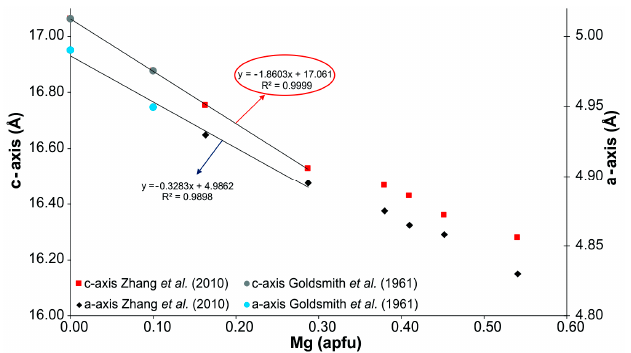
Table 1. Crystallographic cell parameters of Goldsmith et al. [23] and Zhang et al. [38] for calcite with variable Mg contents used to constrain the refinement of magnesian calcite. Figure 1. Dimensions of the crystallographic axes a and c and molar fraction of MgCO 3 , and the respective equations of the lines with their R 2 figure of merit.